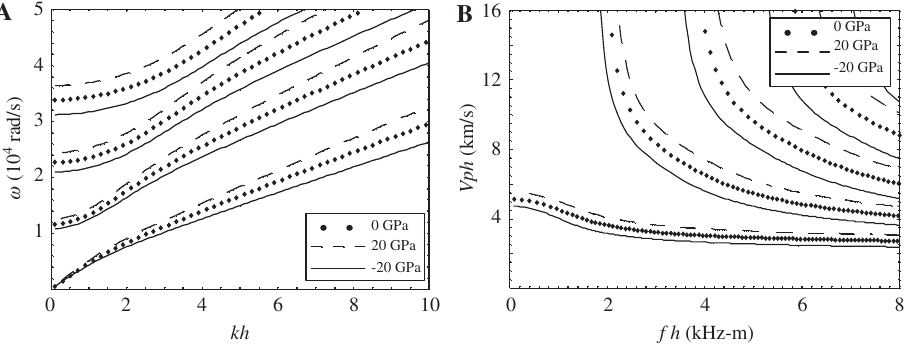
Figure 9 Circumferential SH wave dispersion curves for the linearly graded cylindrical plate with η = 2 under different axial initial stresses: (A) frequency spectra, (B) phase velocity